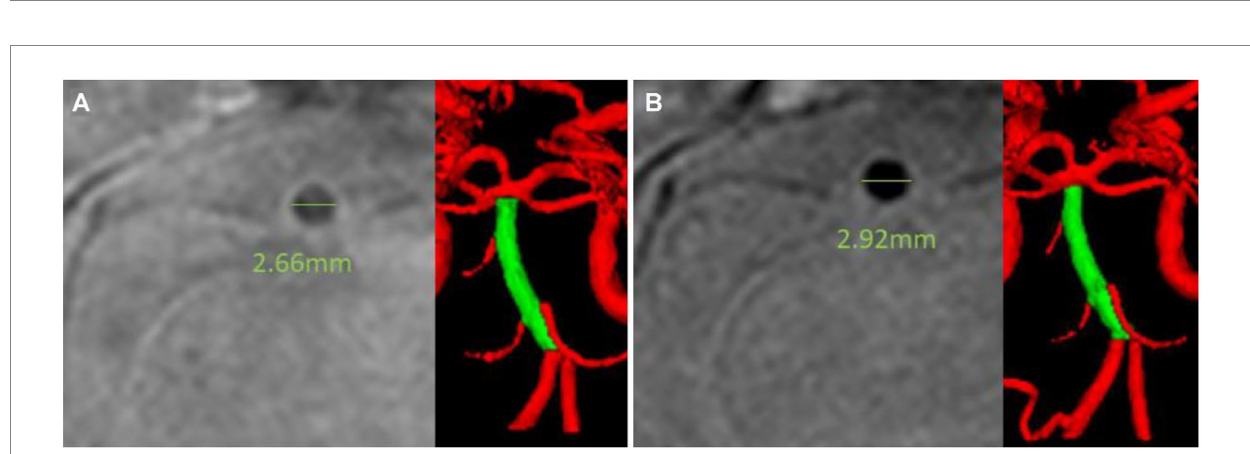
FIGURE 3 Illustrative case showing intracranial arterial lumen diameter changes. A 67-year-old man presented with right middle cerebral arterial territorial infarction. Intensive statin therapy with rosuvastatin 20 mg for 6 months reduced LDL cholesterol level from 164 mg/dl to 46 mg/dl. A high-resolution vessel wall image revealed that the luminal diameter of his basilar artery increased from 2.66 mm (A) to 2.92 mm, (B) although there was no evidence of plaques on the basilar artery segment. The mean luminal maximal diameter of his basilar artery measured by the cerebrovascular morphometry increased by